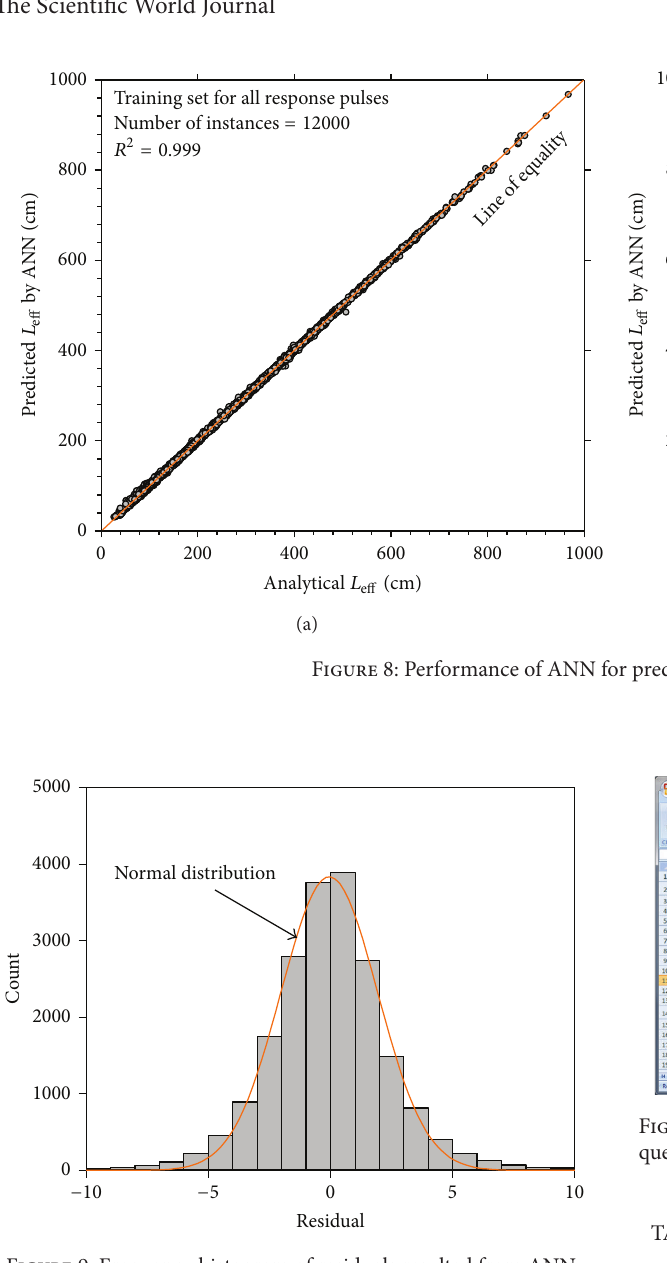
Figure 9: Frequency histogram of residuals resulted from ANN.